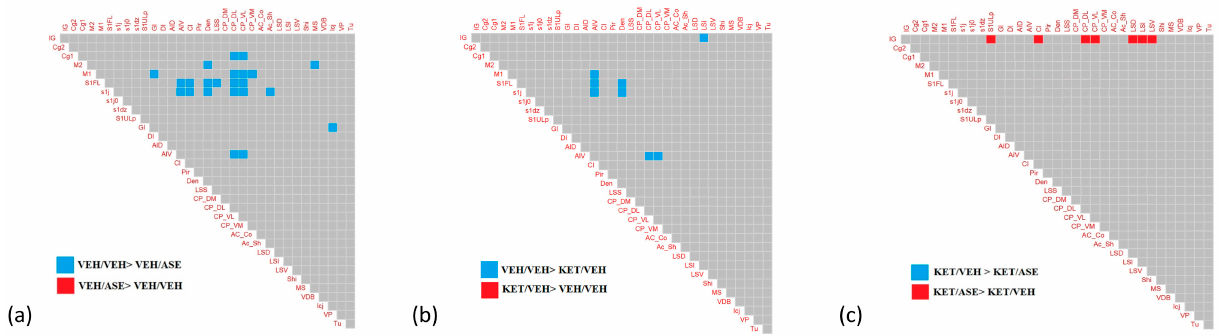
Figure 3. Differences in the pattern of correlation coefficients between groups are displayed in panel ( a ) (VEH/VEH vs. VEH/ASE); panel ( b ) (VEH/VEH vs. KET/VEH); and panel ( c ) (KET/VEH vs. KET/ASE). Blue squares indicate pairs of correlations in which significant differences are positive, red squares indicate couples of correlations in which significant differences are negative. VEH = vehicle; ASE = asenapine; KET = ketamine.